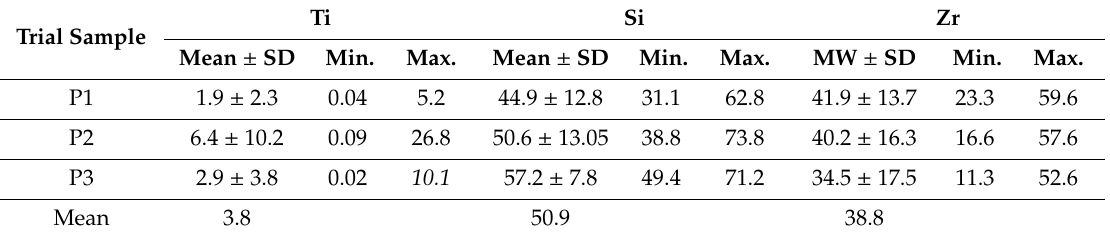
Table 4. Quantitative determination of the elements titanium (Ti), silicon (Si), and zirconium (Zi). Ti Trial Sample Trial Sample